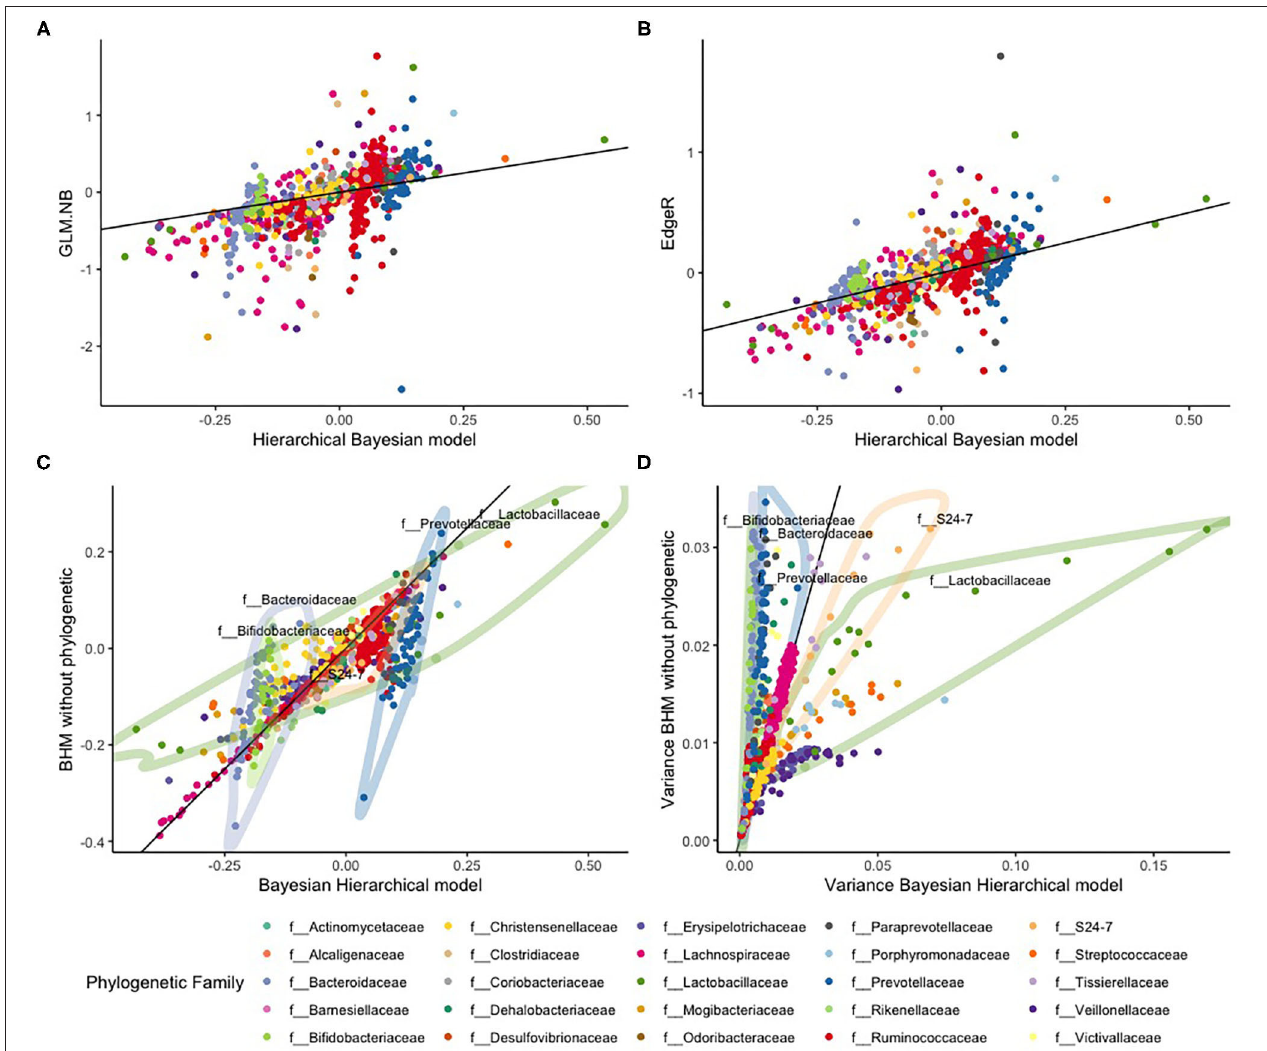
FIGURE 5 | Comparison between the standard NB regression model (GLM.NB), EdgeR, and the Bayesian hierarchical model (BHM) with and without phylogenetic based shrinkage for the HELIUS study data. The top row are the slope estimates from the (A) GLM.NB and (B) EdgeR methods compared to estimates of our BHM. The bottom row gives a comparison between the BHM with and without the phylogenetic based shrinkage: (C) the posterior slope estimates, and (D) the variances of these posterior slopes. The black line in all four figures is the diagonal x =